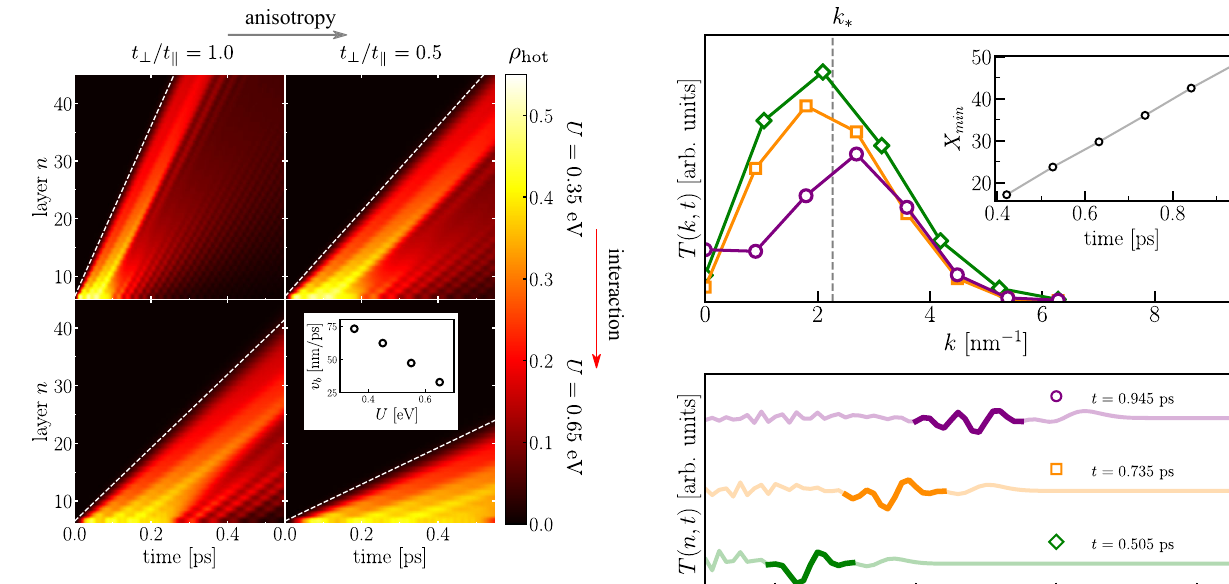
Fig. 4 Control of ballistic energy propagation. The four panels matrix displays the ballistic dynamics of the hot-electron population for varying values of the correlation strength U and anisotropy t ⊥ / t ∥ ( t ∥ = 60 meV). The color scale represents the amplitude of ρ hot ( n , t ) (yellow: maximum; black: minimum). The inset displays the speed v b of the ballistic wavefront for different values of U at t ∥ = t ⊥ . The ballistic wavefronts are highlighted by the dashed lines in the main